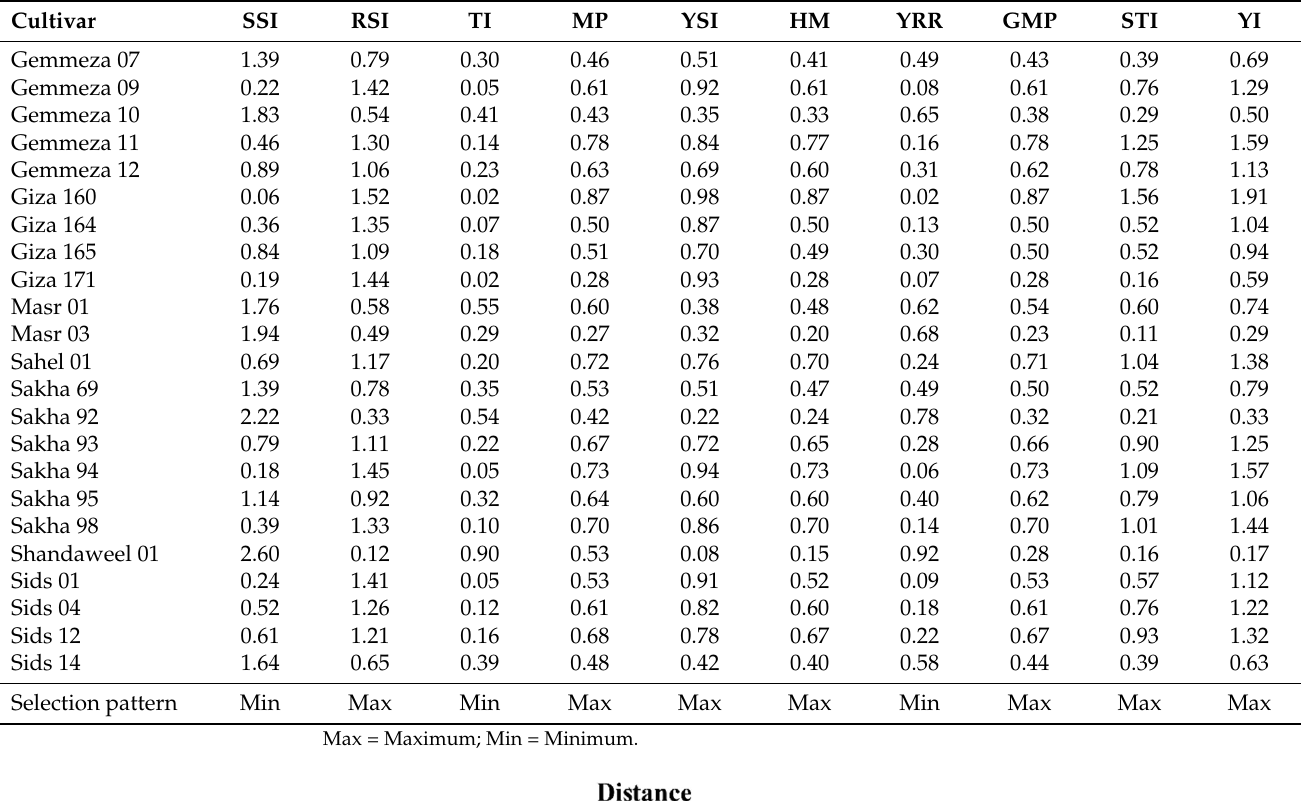
Table 6. Tolerance and susceptibility indices calculated based on a combined average of grain yield.